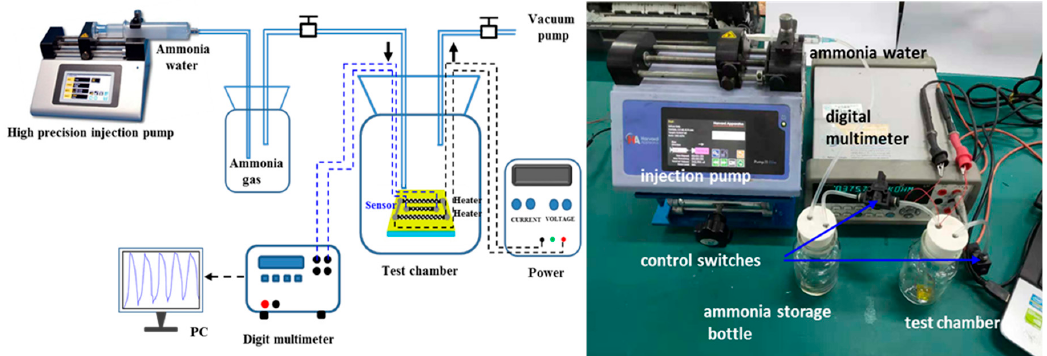
Figure 2. A schematic diagram and a photo of the NH 3 gas sensor testing setup.